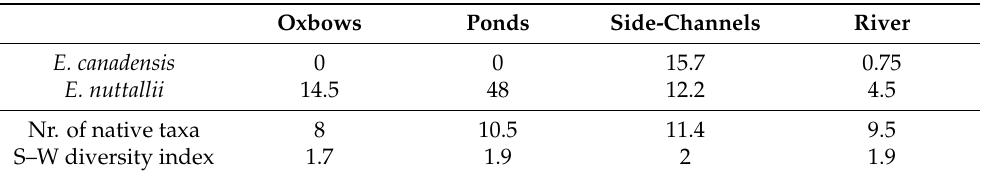
Table 3. Average abundances (in %) of IAS Elodea canadensis and E. nuttallii in four types of waterbod- ies and average values of species-richness and diversity of native